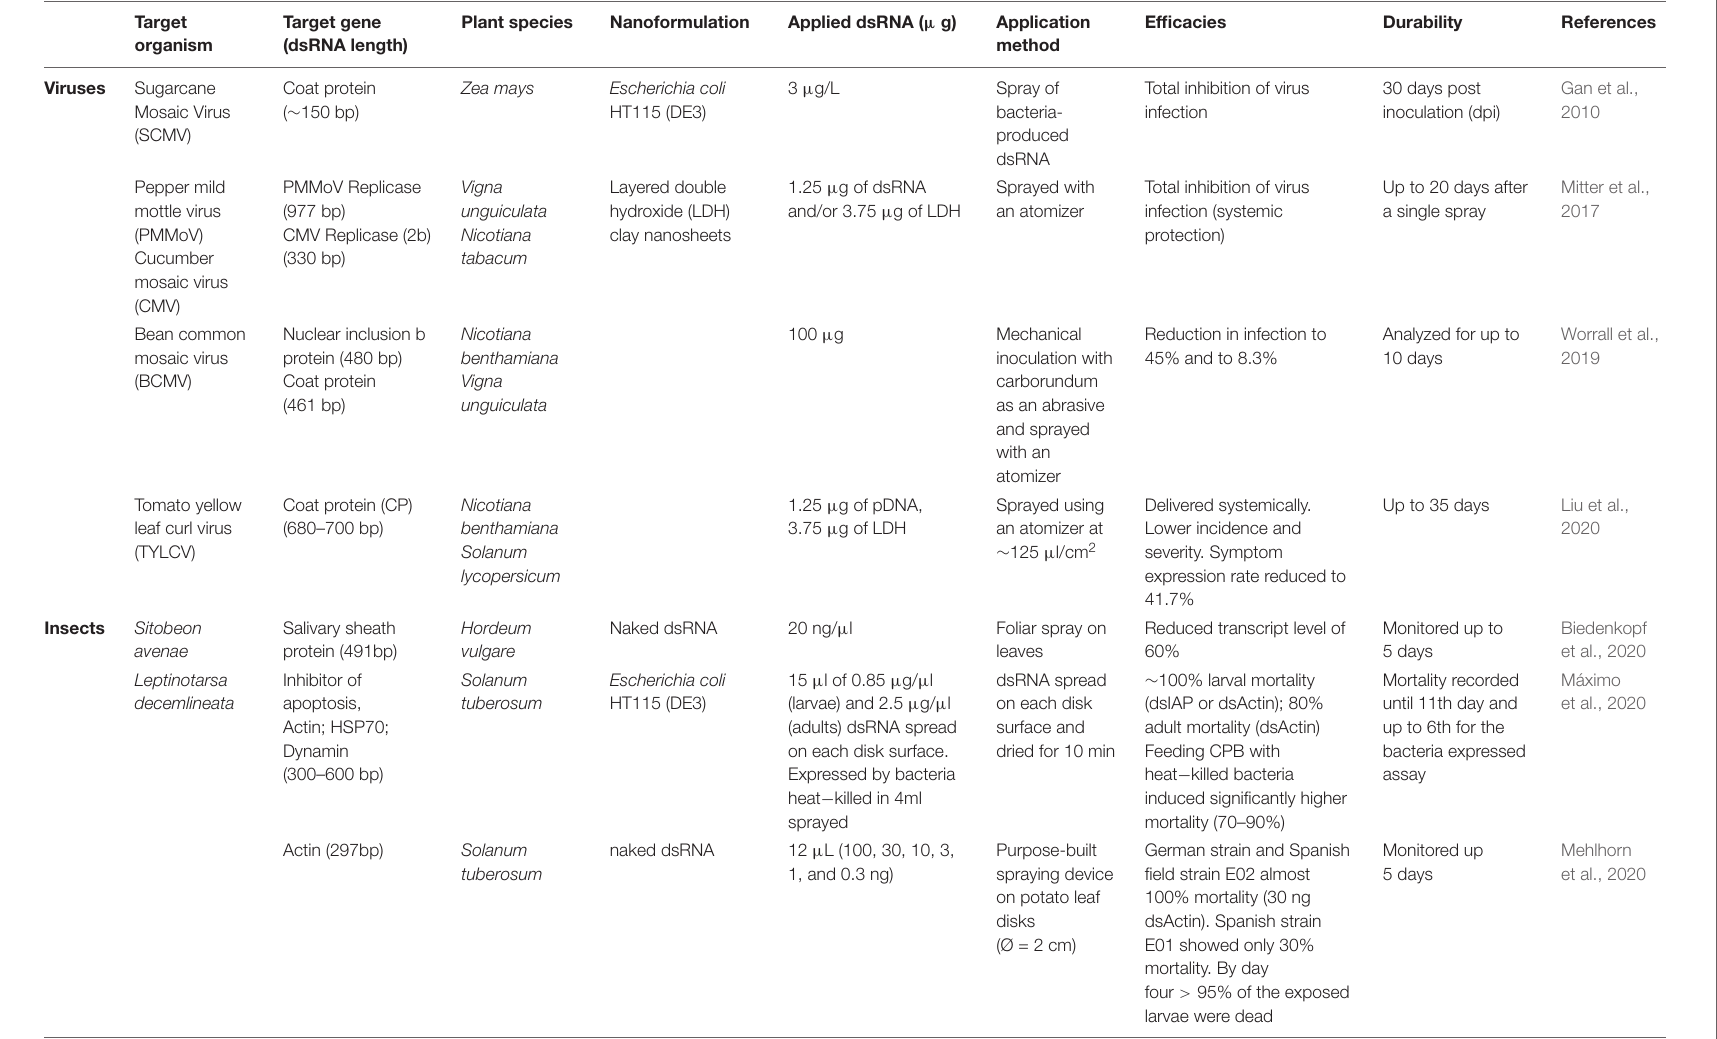
TABLE 1 | Summary of RNA spray studies in